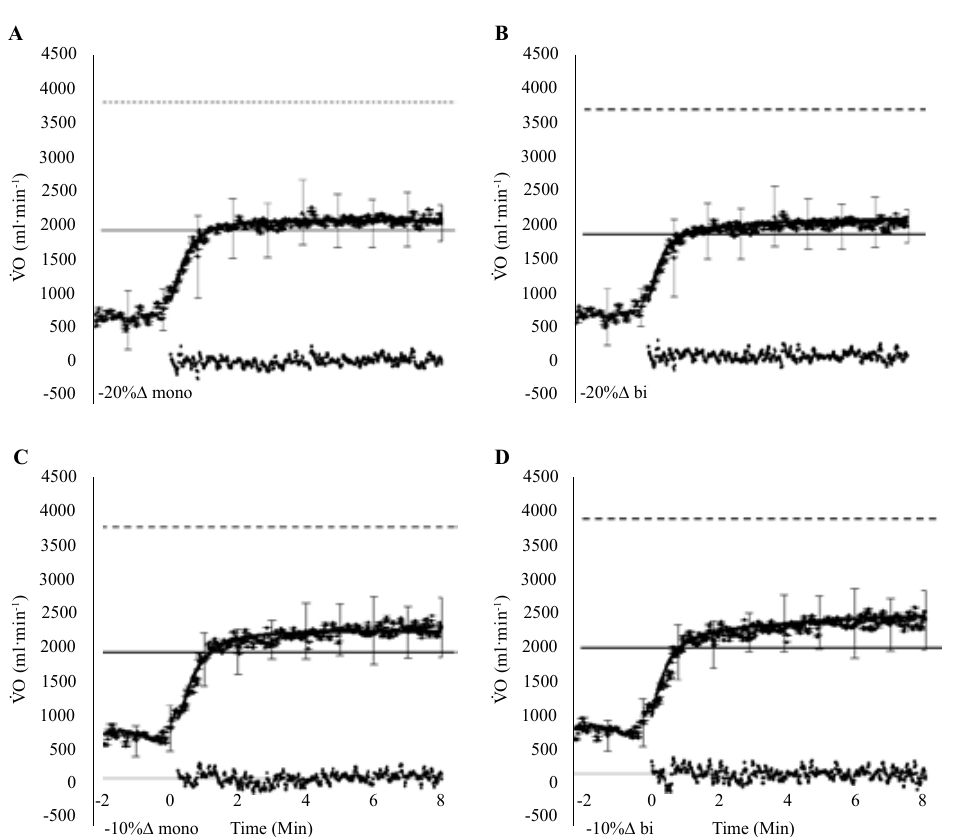
Figure 1. The breath-by-breath oxygen uptake response, mono and bi exponential model fits and residuals across exercise intensity domains in one typical participant. Data from the exercise performed at -20%∆ and -10%∆ are displayed. The V ̇ O